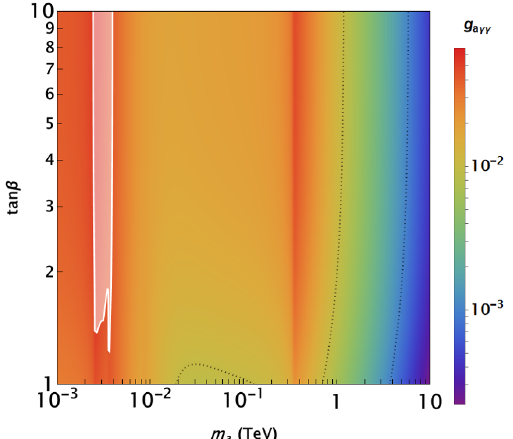
Figure 4 . Parameter space for an ALP mimicking DFSZ axion couplings to fermions, with v a = 100 TeV. The colour code on the background shows how the induced ALP-photon coupling depends on the two free parameters, tan β and m a ; the DFSZ-like ALP couplings to massive gauge bosons present a different dependence. This is in contrast to the linear one on N Y and N L that all ALP- EW gauge boson coupling present in the pure EFT approach. A naïve projection of FCC-ee reach is shown in